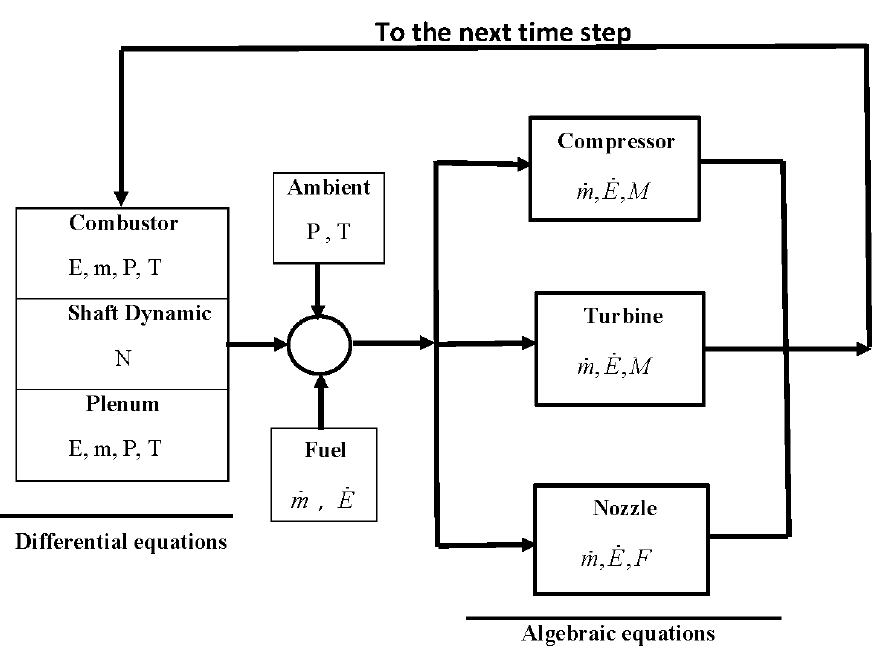
Figure 3. Numerical solution procedure for the modeling of jet engines.